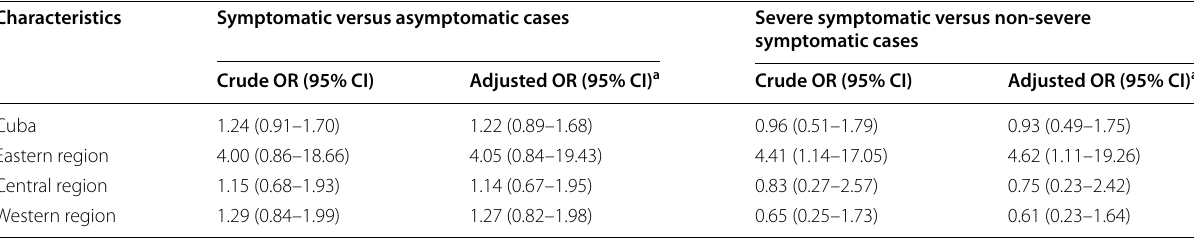
Table 4 Crude and adjusted odds ratios for different levels of severity of SARS‑CoV‑2 infection according to the presence of the TNFα 308.A allele by −